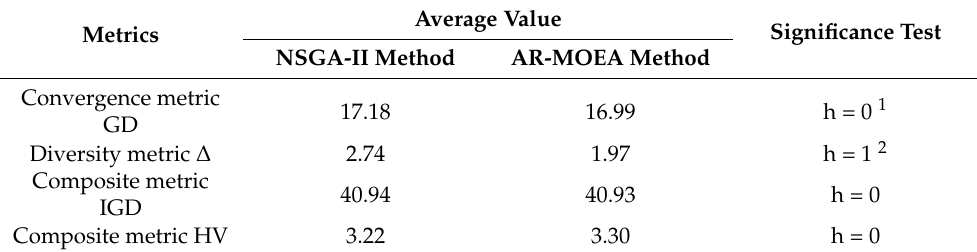
Table 2. The average value and significance test of algorithm performance metrics of the two methods running for 30